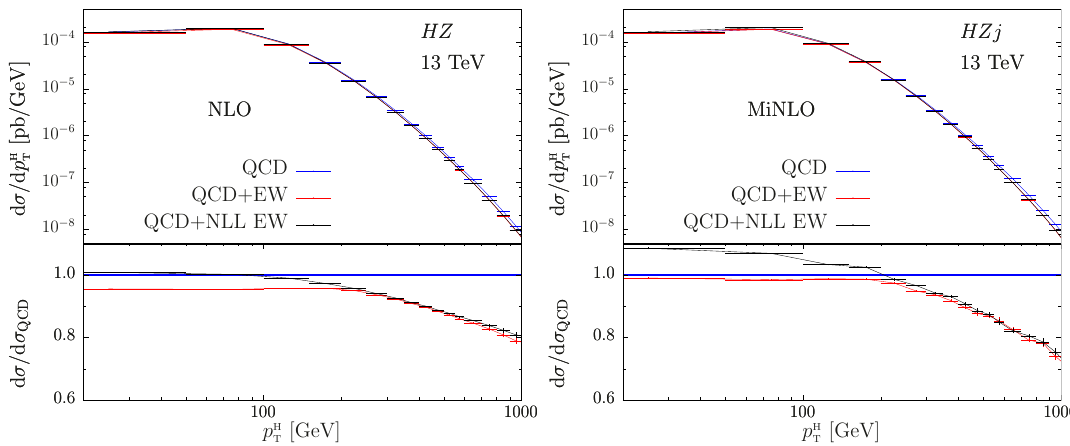
Figure 9. NLO predictions for the Higgs boson transverse momentum in HZ (left) and HZj (right) production. Same curves and labels as in (cid:12)gure